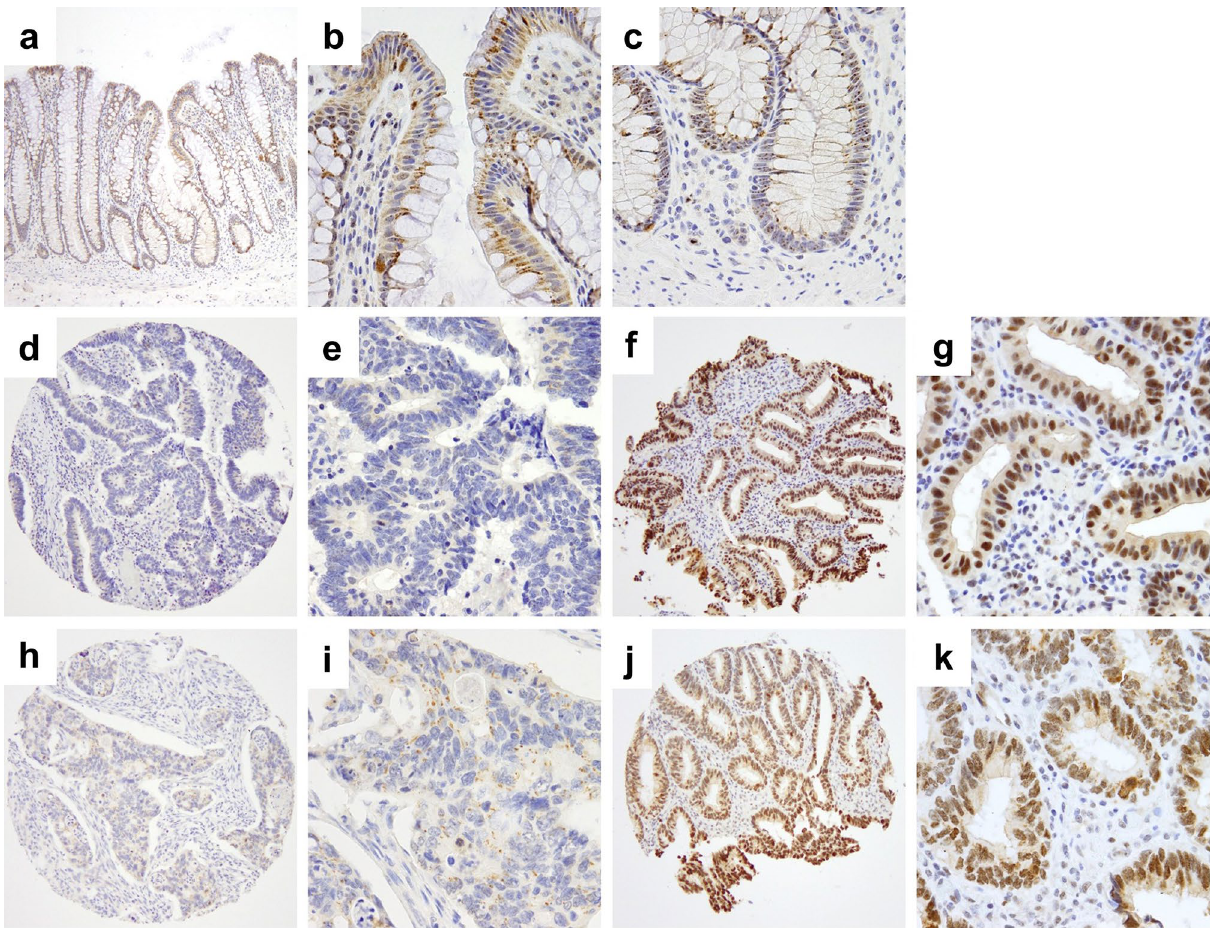
Figure 2. Representative DDX21 protein detection by immunohistochemistry of TMA cores. ( a-c ) Benign colonic mucosa with negative or weak cytoplasmic or weak nucleolar staining for DDX21 in enterocytes. ( d , e ) Representative early stage colorectal cancer with negative staining for DDX21. ( f , g ) Representative early stage colorectal cancer with strongly positive nuclear DDX21 staining in cancer cells. Note the absence of staining in stromal cells of the lamina propria. ( h , i ) Representative late stage colorectal cancer with negative staining for DDX21. ( j , k ) Representative late stage colorectal cancer with strongly positive nuclear DDX21 staining in cancer cells. Note the absence of staining in stromal cells of the lamina propria. Original magnifications: ×20 ( a , d , f , h , j ) and ×200 ( b , c , e , g , i , k